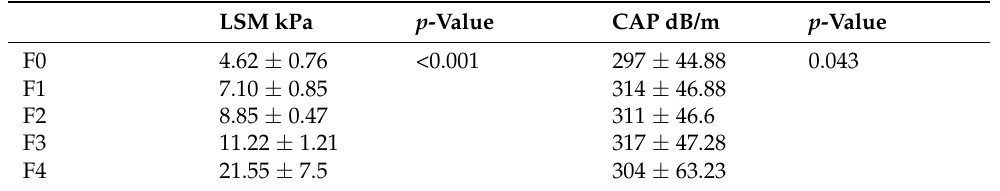
Table 5. Comparison of LSM and CAP values according to fibrosis